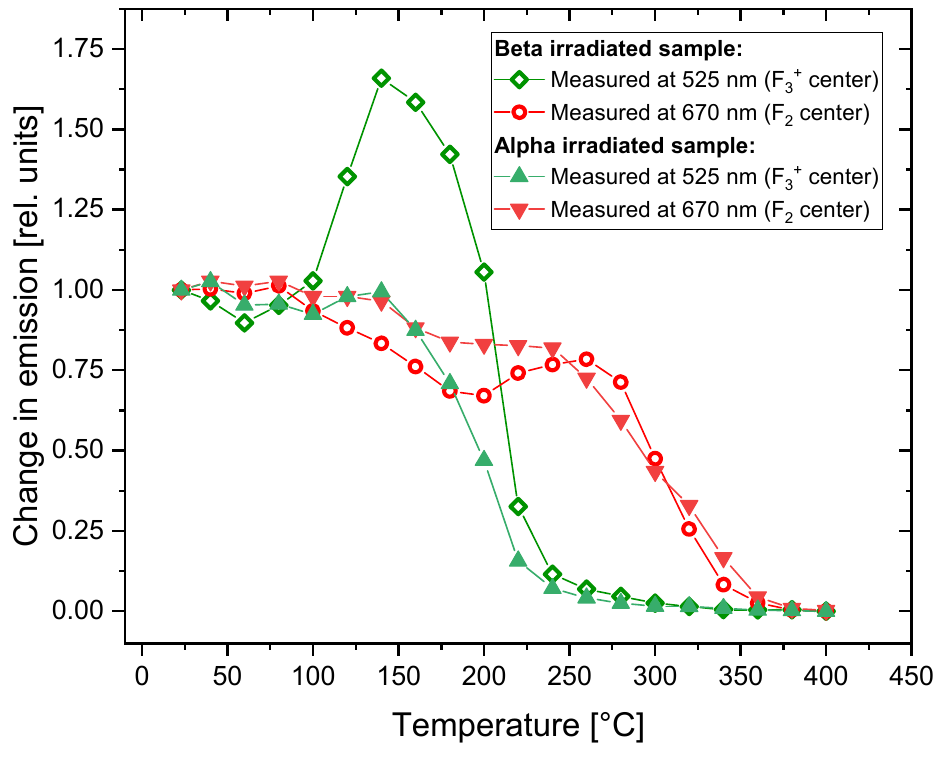
Figure 7. Relative changes in PL intensity at various temperatures with respect to the values at RT measured for two bands at 525 nm and 670 nm after the treatment according to Method 1. Changes were measured for the beta-irradiated (30 kGy) and alpha-irradiated (fluence 3.4 × 10 12 cm − 2 ) sam ‐ ples.